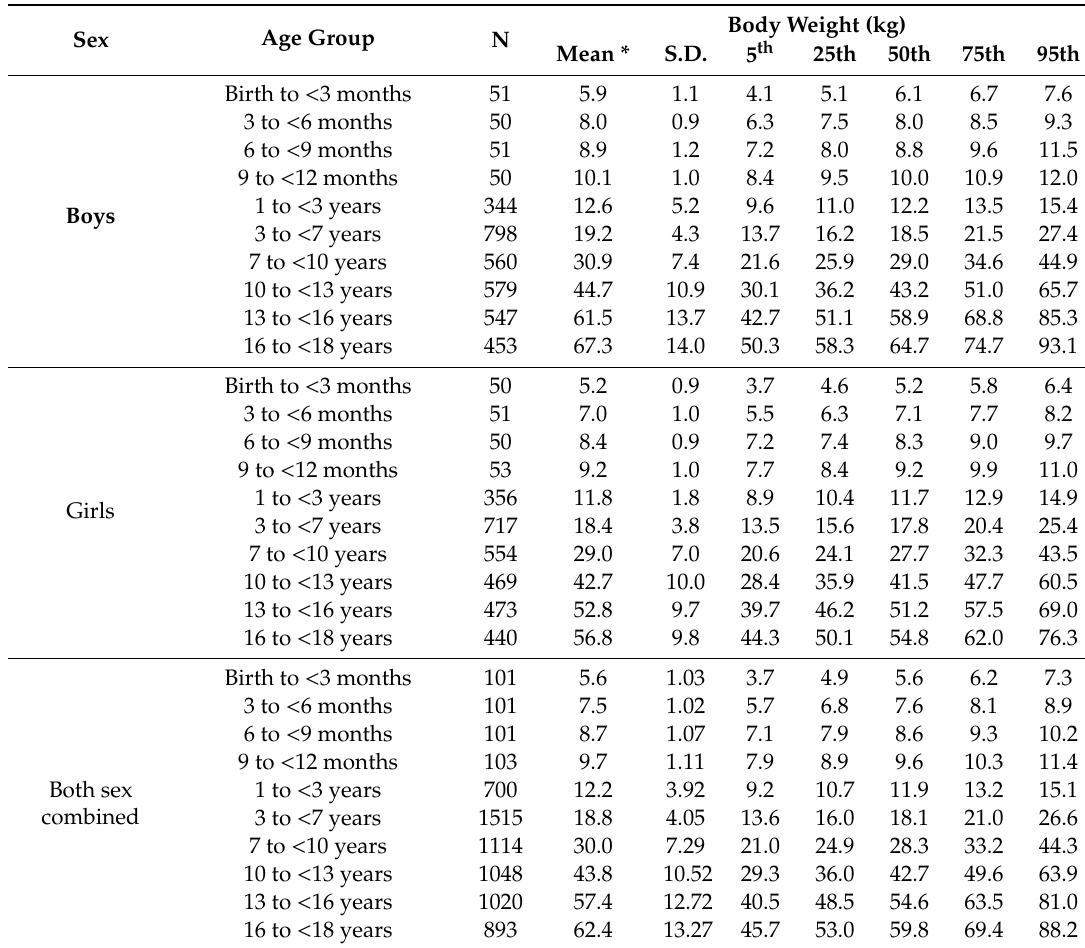
Table 1. Recommended values and statistics for body weight according to age